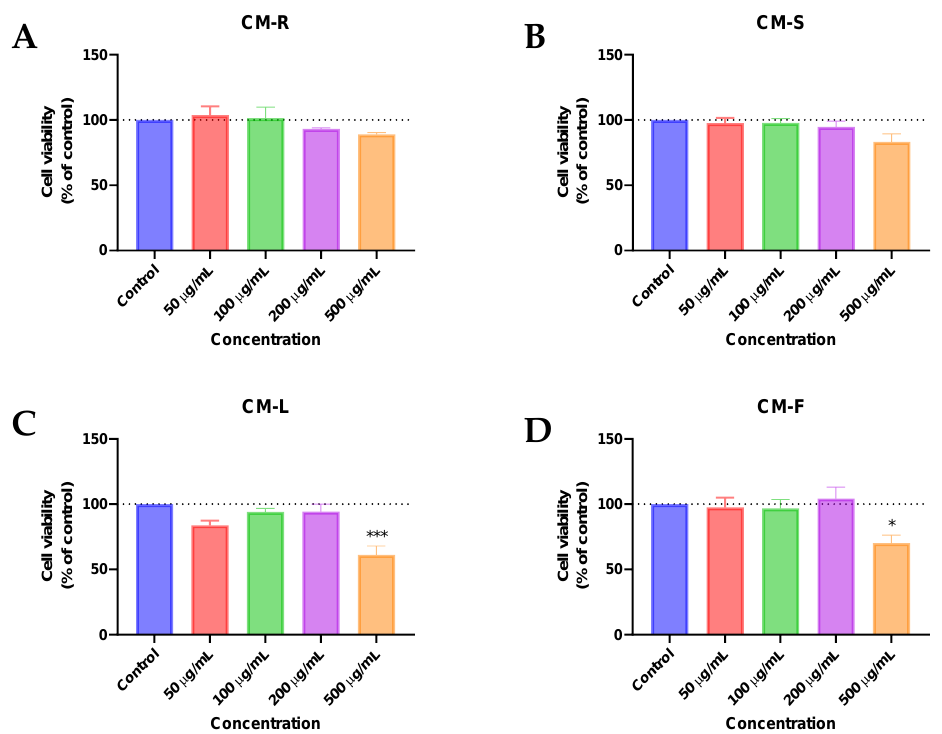
Figure 1. Biosafety evaluation of Cladanthus mixtus extracts on MRC-5 cells after 48 h of treatment. ( A ): root extract, ( B ): stem extract, ( C ): Leaf extract, ( D ): flower extract. Data are given as the mean ± SEM (n = 3), * statistically significant vs. control (vehicle) at p < 0.05; *** statistically significant vs. control (vehicle) at p < 0.001.